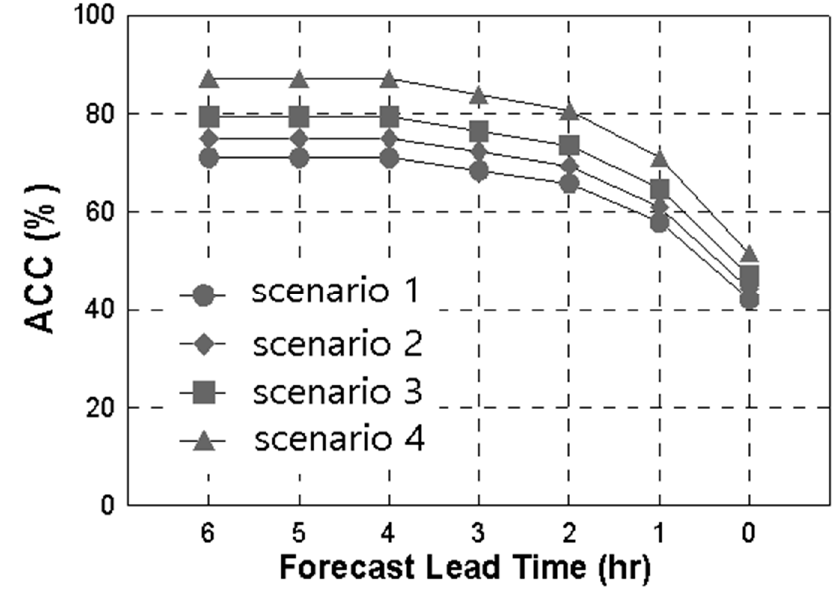
Figure 10. Accuracy of flash flood occurrence with respect to preceding time.